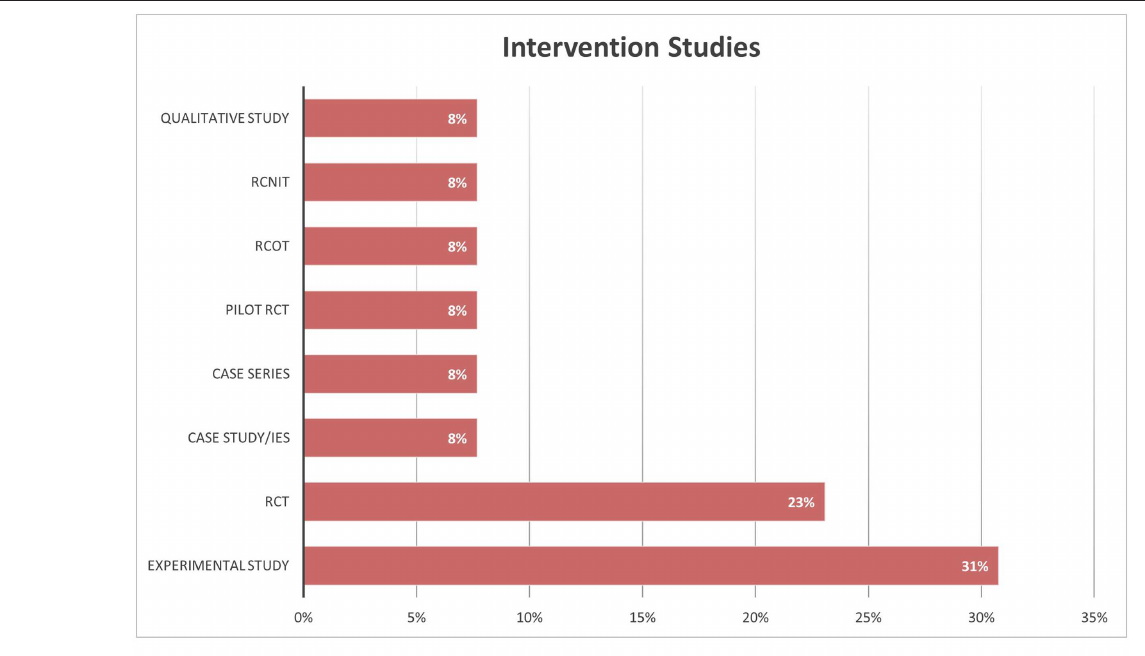
FIGURE 6 | Summary of the distribution of intervention studies for research design